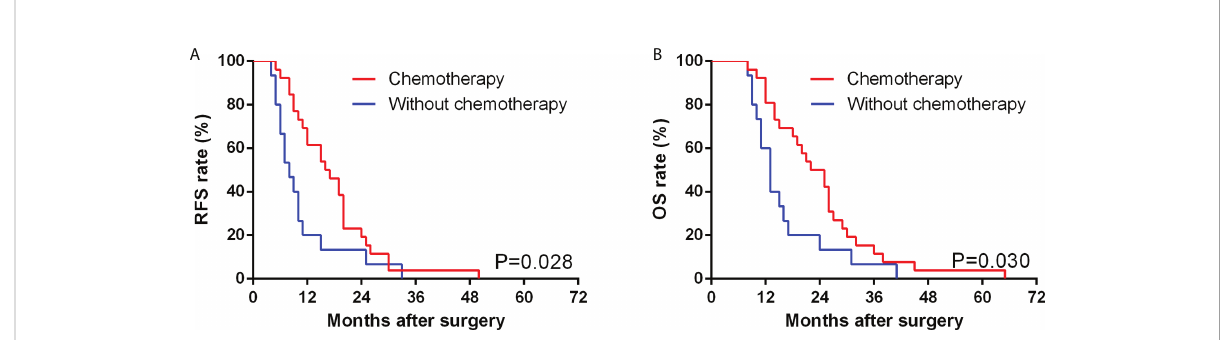
FIGURE 3 Comparison of RFS (A) and OS (B) between GBSC patients who underwent curative surgery with and without chemotherapy by Kaplan − Meier analysis. (Among the GBSC patients who underwent curative surgery, 26 received postoperative chemotherapy, while 15 of them received strictly following up alone without postoperative chemotherapy).